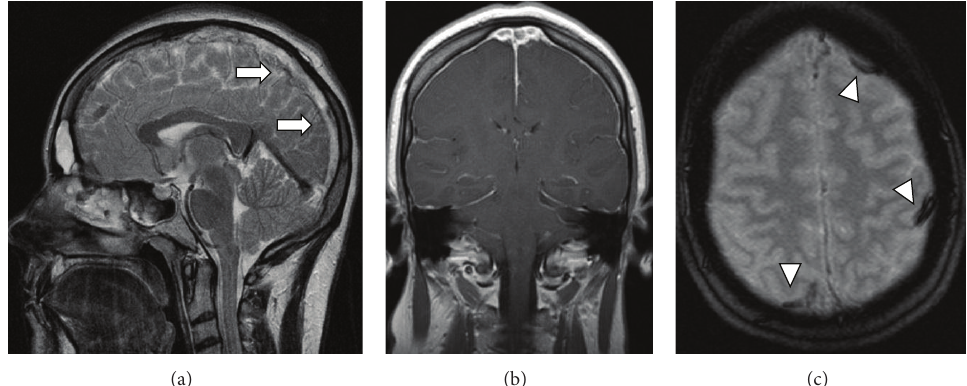
Figure 1: Brain MRI. (a) Sagittal T2-weighted image, (b) coronal T1-weighted image, and (c) axial gradient-echo image show superior sagittal sinus thrombosis (arrow) and thrombosis of multiple cortical cerebral veins (arrowheads).